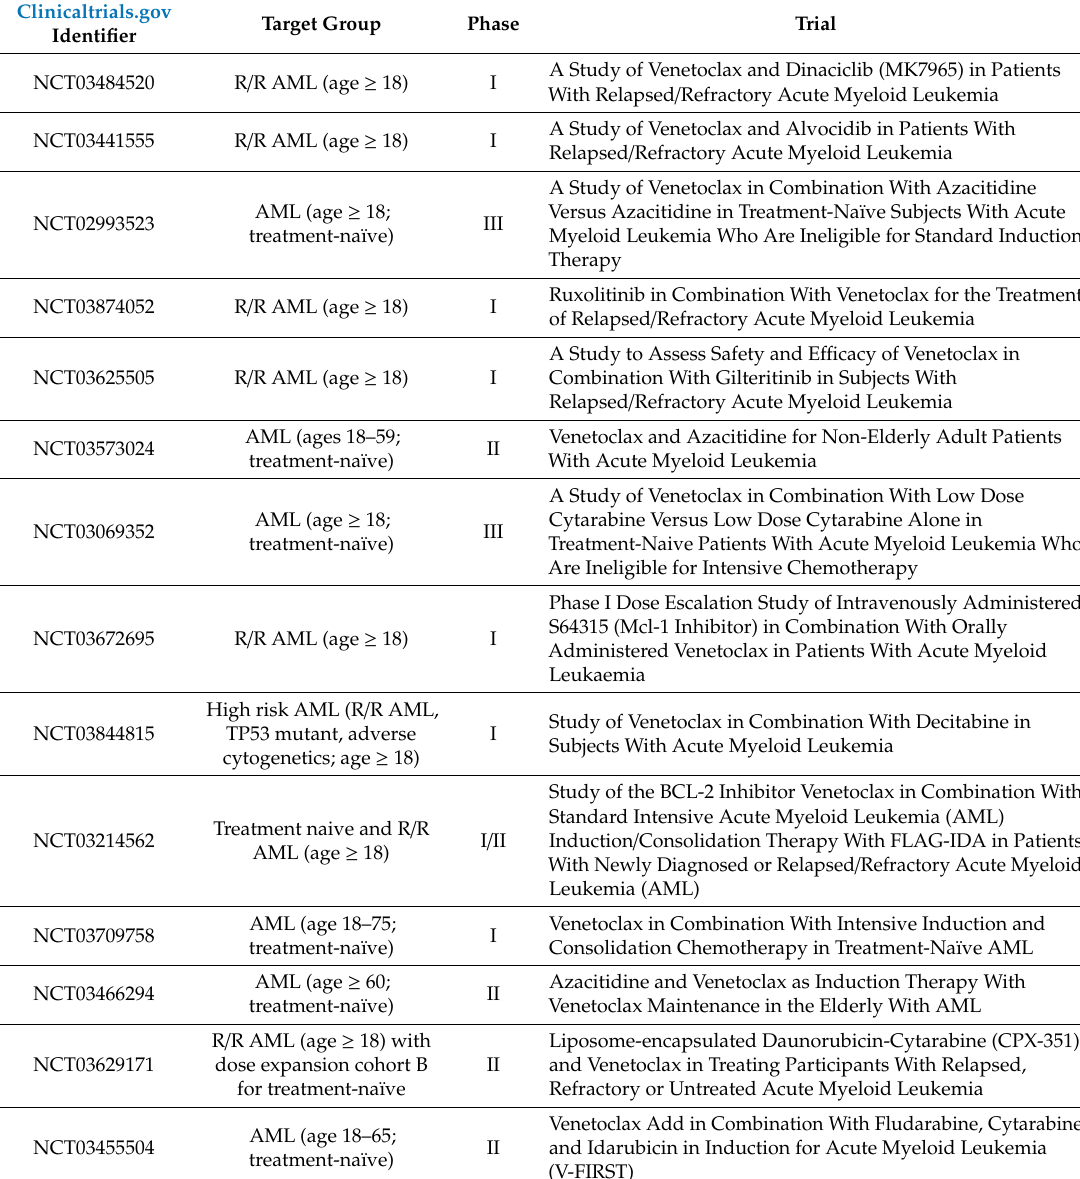
Table 1. Ongoing clinical trials using BCL-2 Inhibitors in Acute Myeloid Leukaemia. Clinicaltrials.gov